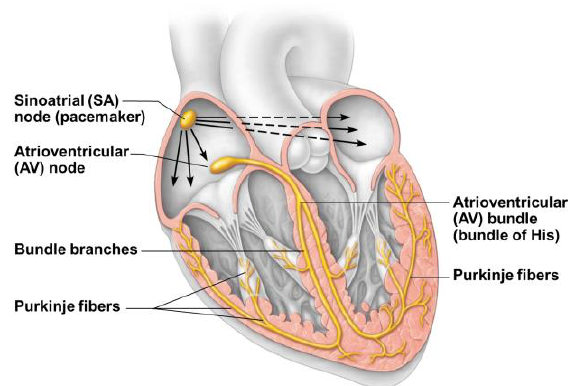
Figure 5. Adult heart conduction system that depicts the original single starting point in the ex sinus venosus area (sino-atrial node), the atrioventricular node and the subsequent more capillary branches that follow the myofibrillar development of cardiac ventricles.